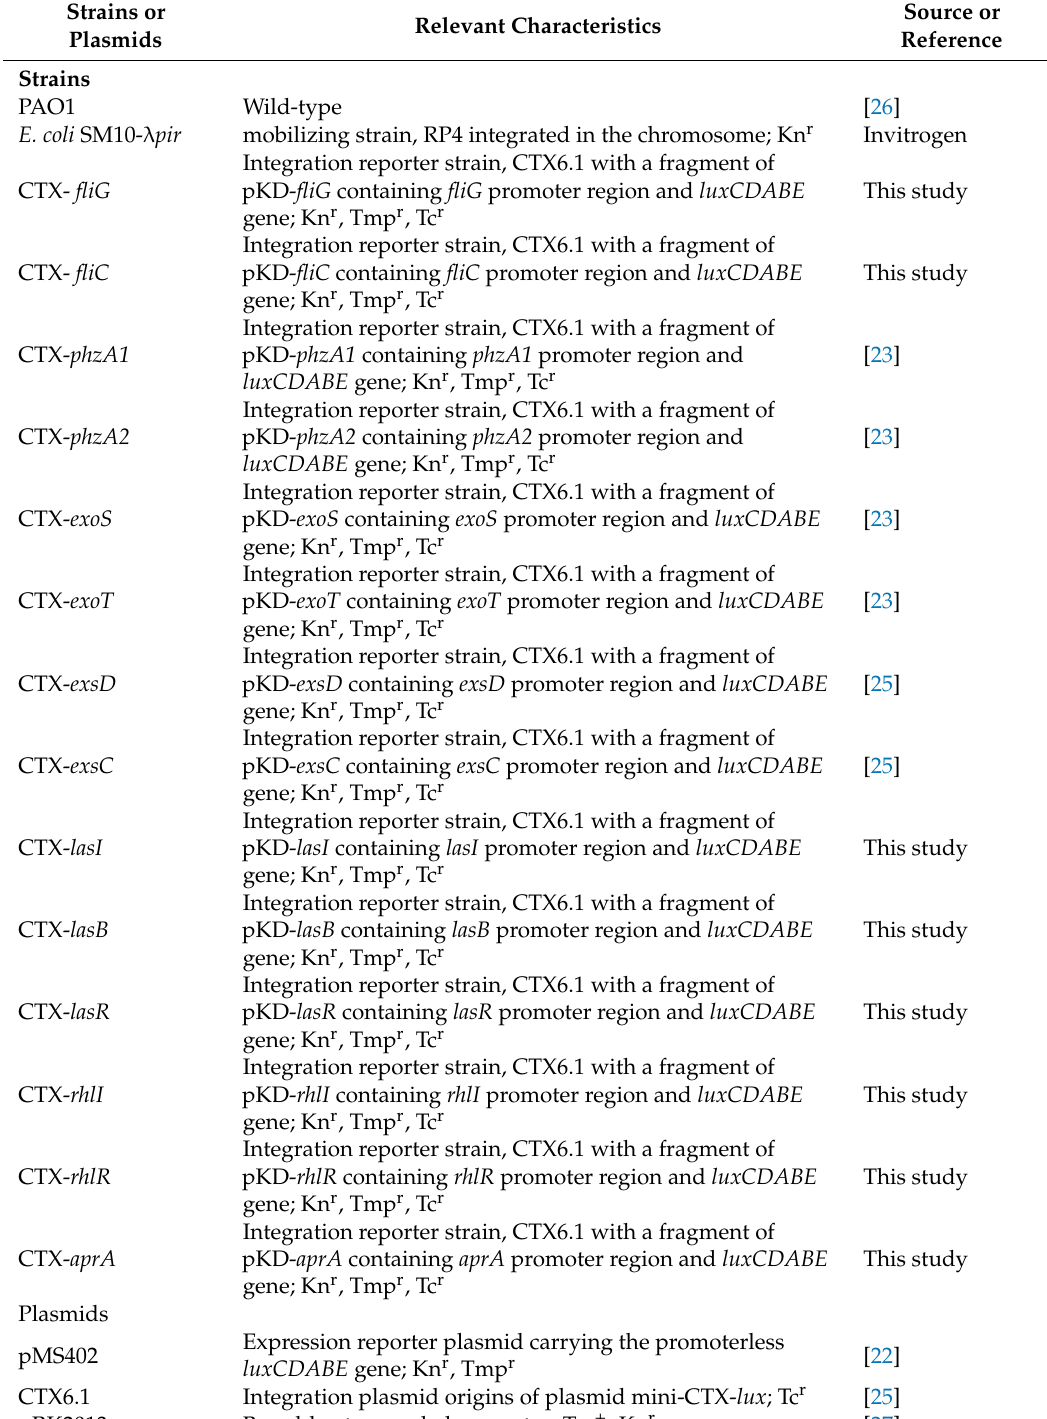
Table 1. Bacterial strains and plasmids used in this